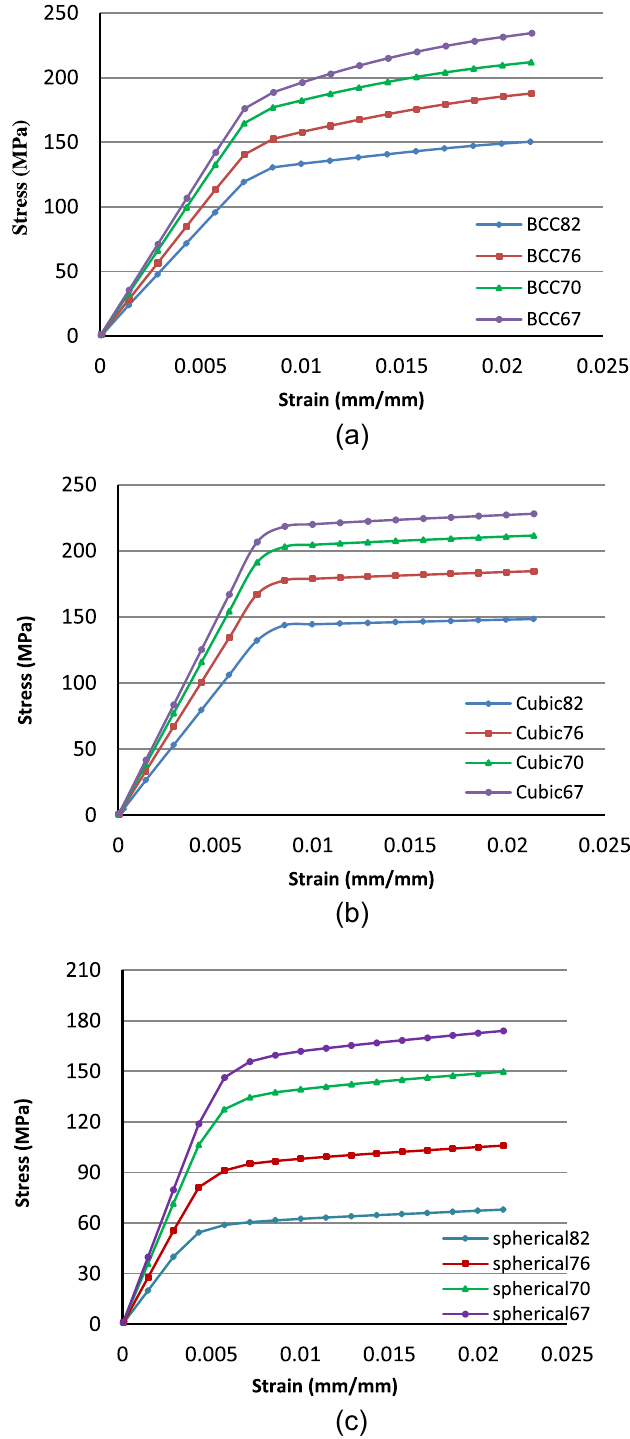
Fig. 6. Stress – strain curves obtained using the FE analysis of porous structures with different porosities; (a) BCC, (b) Cubic, and (c) Spherical.